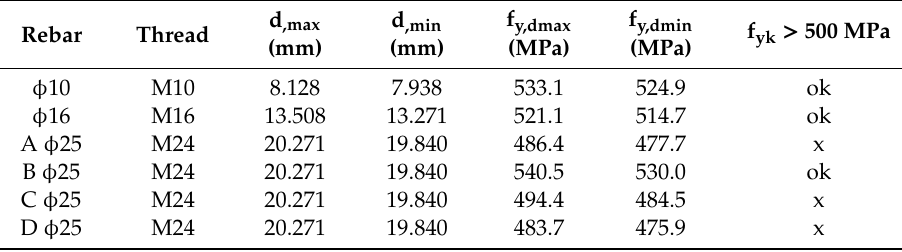
Table 5. The yield strength of thread